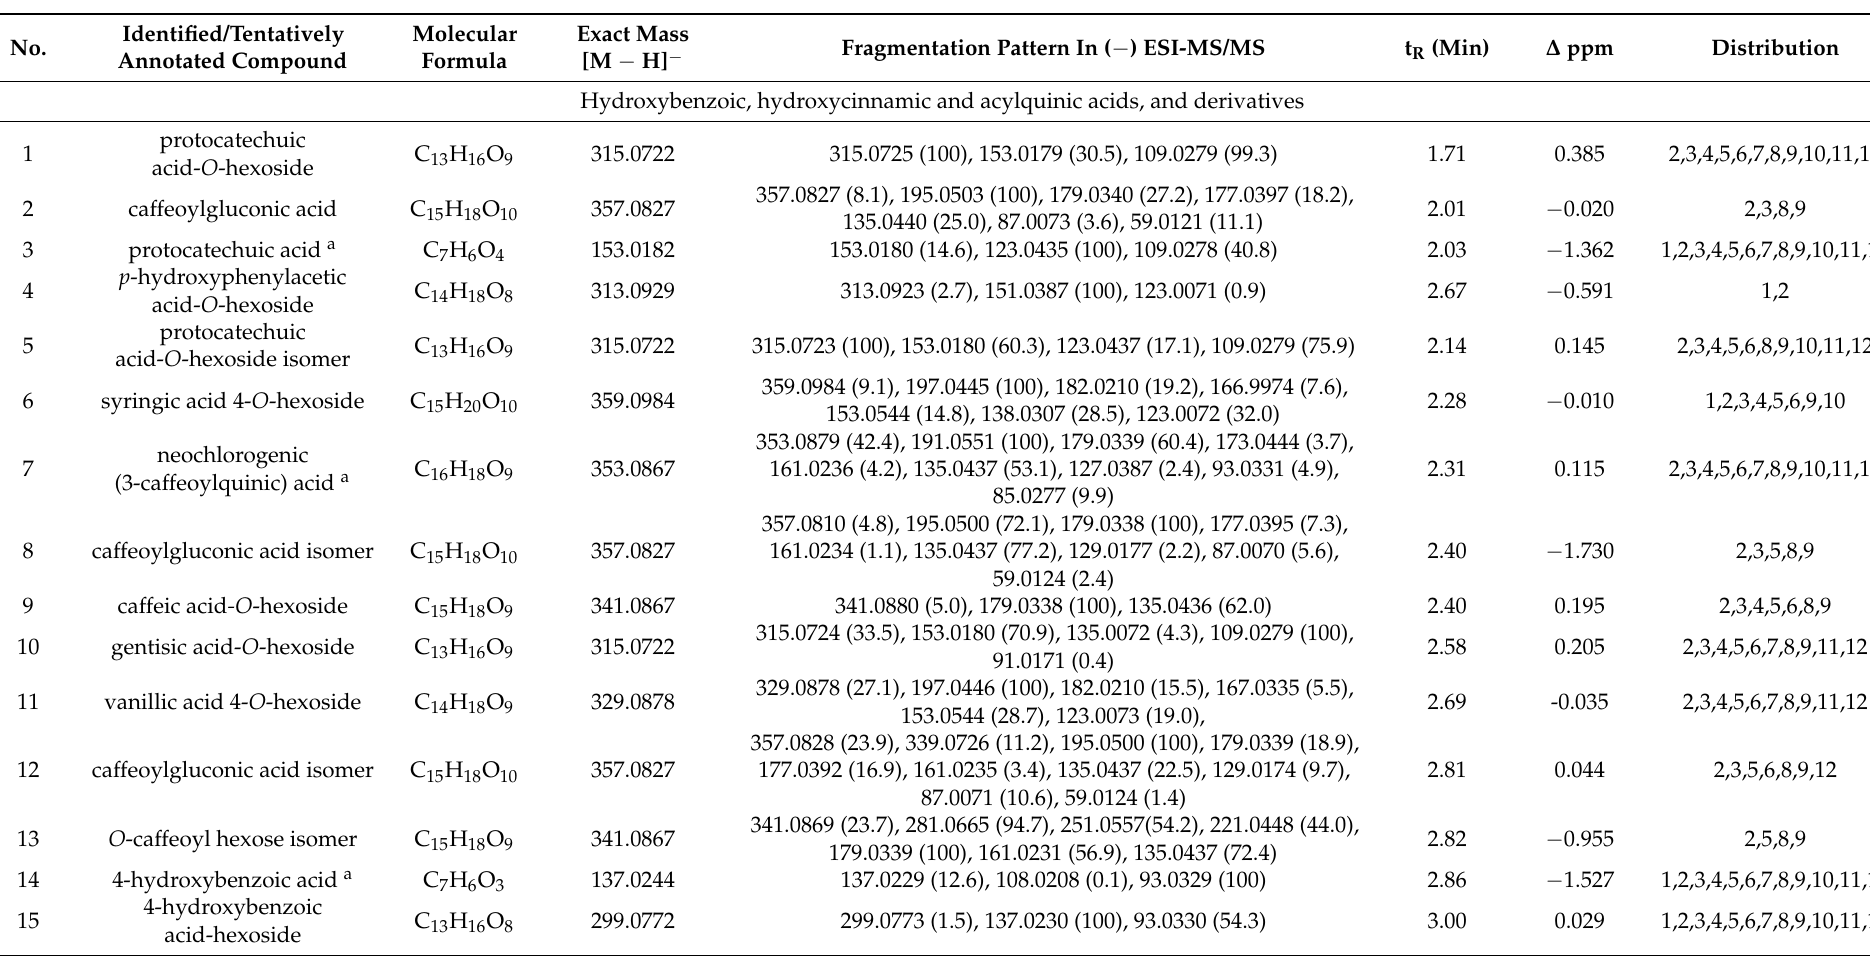
Table 2. Secondary metabolites in the studied Achillea extracts by UHPLC-ESI-MS/MS. Compound distribution is reported in the last column and different part and extracts are numberedas follows: 1. A. allepica -Aerial parts-EA; 2. A. allepica -Aerial parts-MEOH; 3. A. allepica -Aerial parts-WATER, 4. A. allepica -Roots-EA, 5. A. allepica -Roots-MEOH, 6. A. allepica -Roots-WATER, 7. A. santolinoides -Aerial parts-EA, 8. A. santolinoides -Aerial parts-MEOH, 9. A. santolinoides -Aerial parts-WATER, 10. A. santolinoides -Roots-EA, 11. A. santolinoides -Roots-MEOH, 12. A. santolinoides -Roots-WATER. a,b compound identity is confirmed by comparison with reference